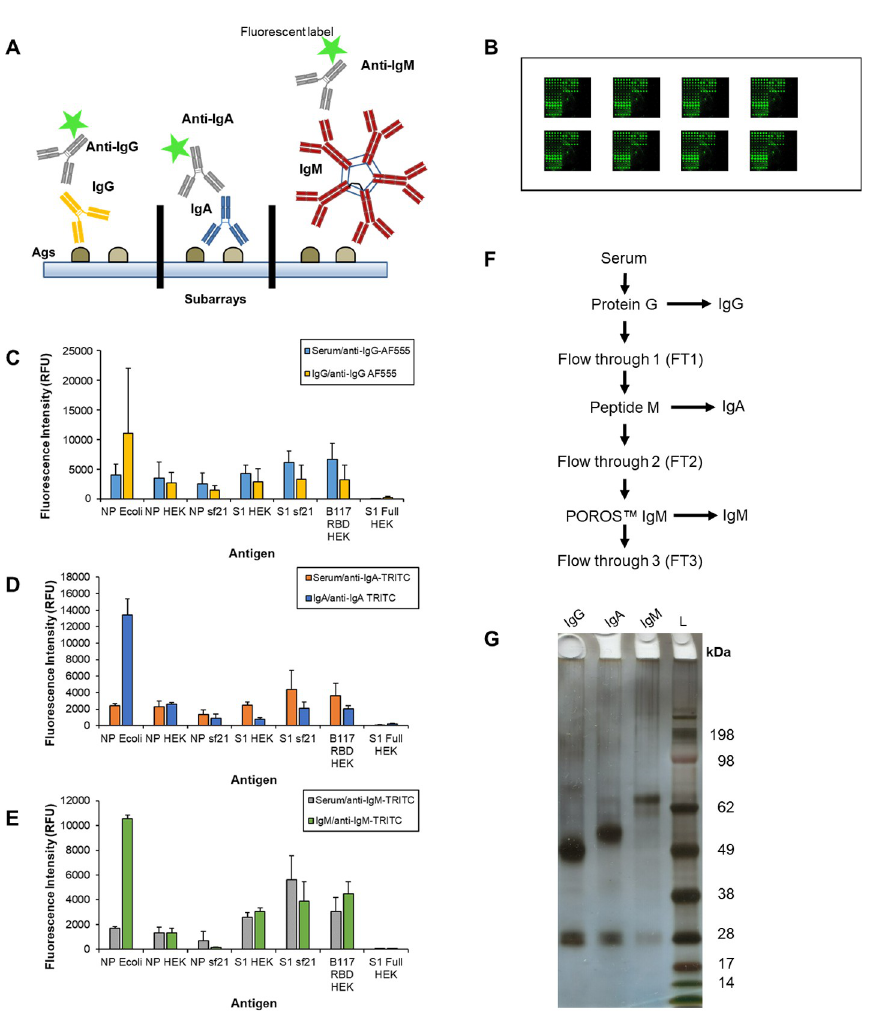
Fig 1. Construction and optimisation of a SARS-CoV-2 protein antigen microarray and fractionation of serum immunoglobulins. (A) Cartoon of SARS-CoV-2 protein antigens conjugated to a microarray surface in replicate subarray format. Each subarray was incubated with a purified serum antibody isotype and serum antibody binding to specific antigens was detected using fluorescently labelled anti-isotype antibodies. (B) Cartoon of a typical SARS-CoV- 2 antigen microarray slide with six replicate subarrays. (C) Bar charts representing the binding intensity of diluted serum (1/100 in PBS-T) and purified serum (C) IgG, (D) IgA, and (E) IgM from a COVID-19 patient (203-0018-1) detected by the appropriate fluorescently-labelled anti-isotype antibody. (F) Flow chart depicting sequential serum immunoglobulin isotype purification procedure. (G) Purified serum IgG, IgA, and IgM (1 μ g each) from a